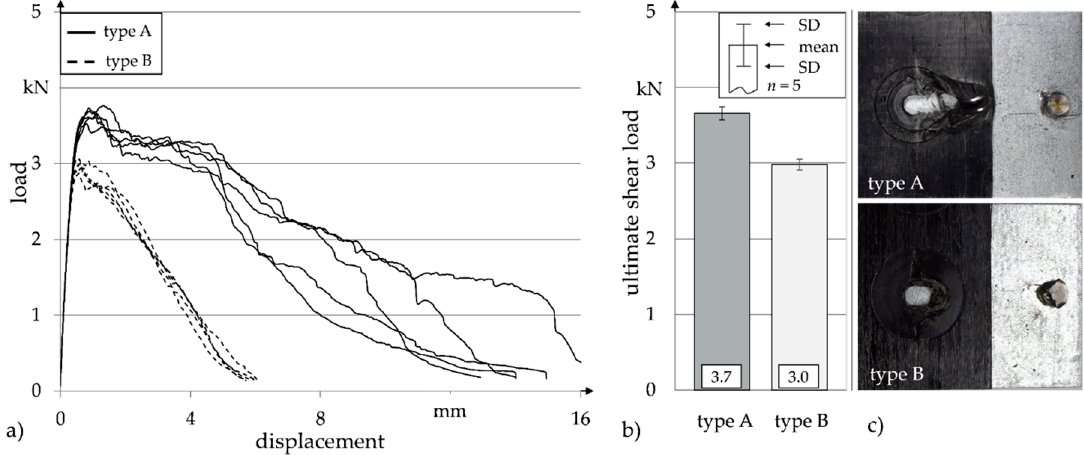
Figure 11. Results of single-lap shear tests under quasi-static load for both types of weld inserts: ( a ) load-displacement curves, ( b ) ultimate shear load, ( c ) characteristic failure behaviour.